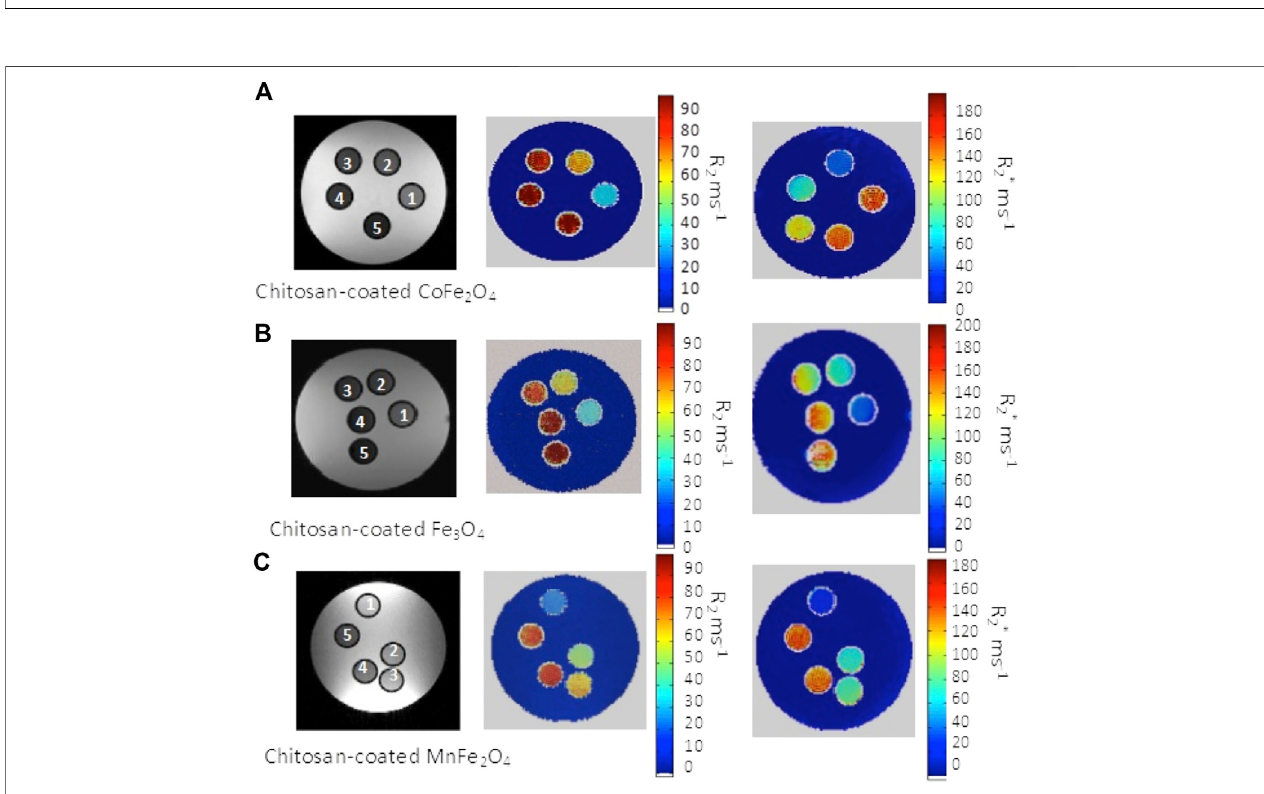
FIGURE 12 | In vitro MR images of water phantoms containing chitosan coated (A) CoFe 2 O 4 , (B) Fe 3 O 4 and (C) MnFe 2 O 4 spinel ferrites of inside the fi ve tubes at different concentration demonstrating contrast for each composition with respect to water (in each image 1 to 5 represents lowers to higher concentration) with T 2 weighted spin-echo image and R 2 and R 2 * mapping are